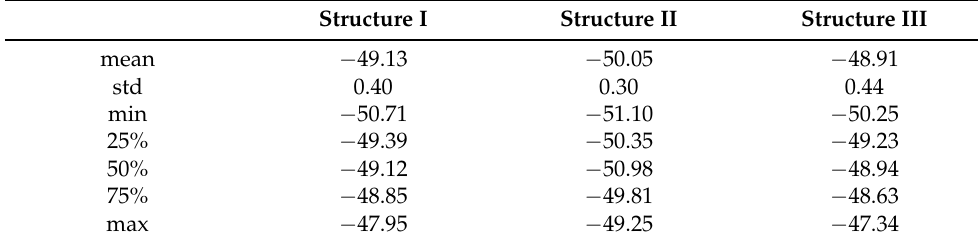
Table 2. Statistical analysis of energy fluctuations in VASP MD